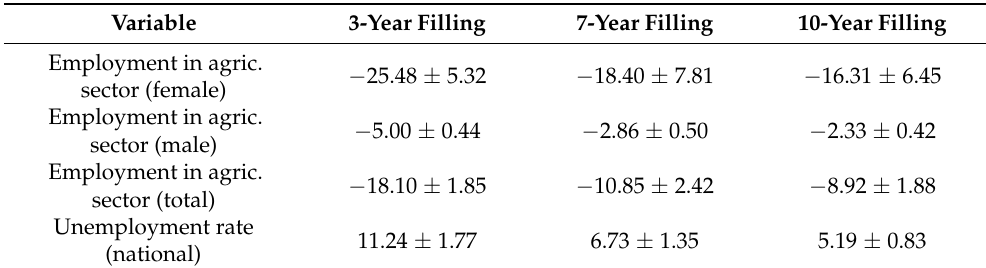
Figure 7. Projected trends in ( a ) female employment in the agricultural sector, ( b ) male employment in the agricultural sector, ( c ) total employment in the agricultural sector (male and female), and ( d ) the national unemployment rate under the alternative filling scenarios. Table 6. Average annual change (%) in agricultural sector employment and the national unemploy- ment rate relative to the benchmark (no GERD)